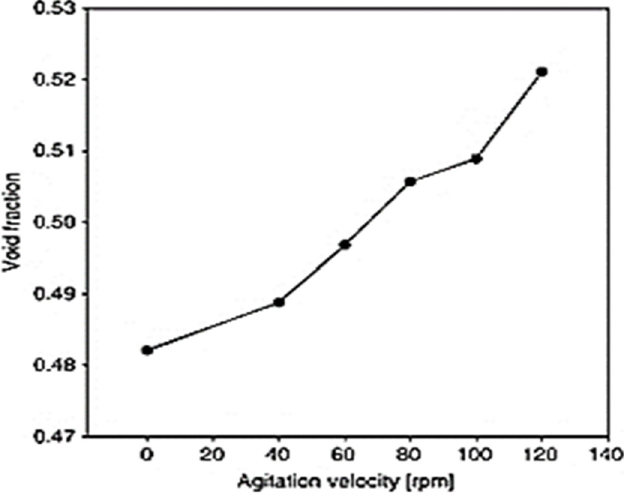
Figure 18. Graph showing an increase in the void fraction of powder material with agitation speed [149].